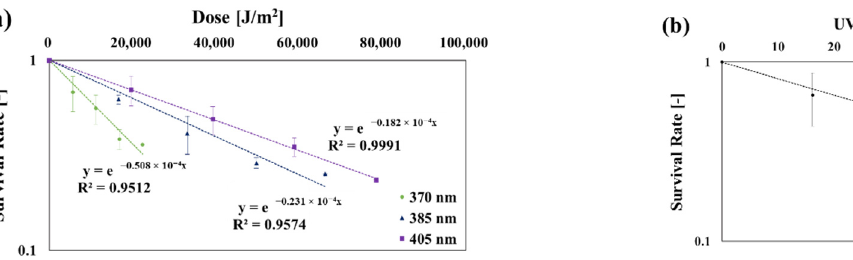
Figure 3. Inactivation rates (±std) of the four microorganisms by LED wavelength. (n indicates the number of replicates experiments.) ( a ) Reduction rate with microorganisms at 275 nm. ( b ) Reduction rate with microorganisms at 370 nm. ( c ) Reduction rate with microorganisms 385 nm. ( d ) Reduction rate with microorganisms 405 nm.